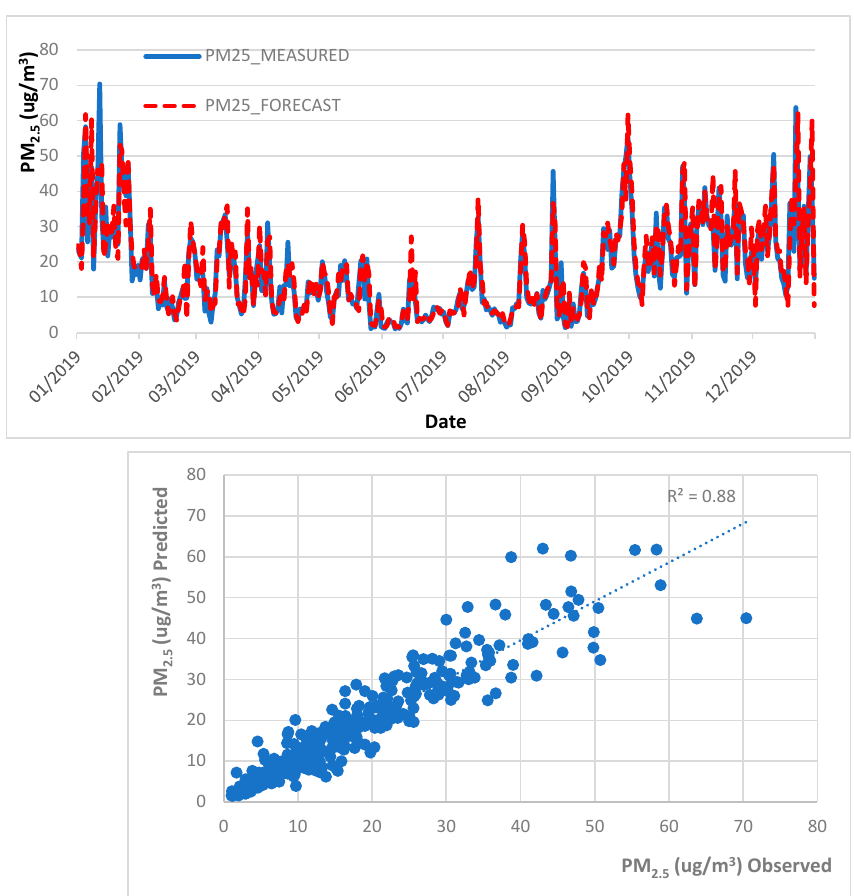
Figure 2. Observed and predicted PM 2.5 concentrations using RF for the year 2019.